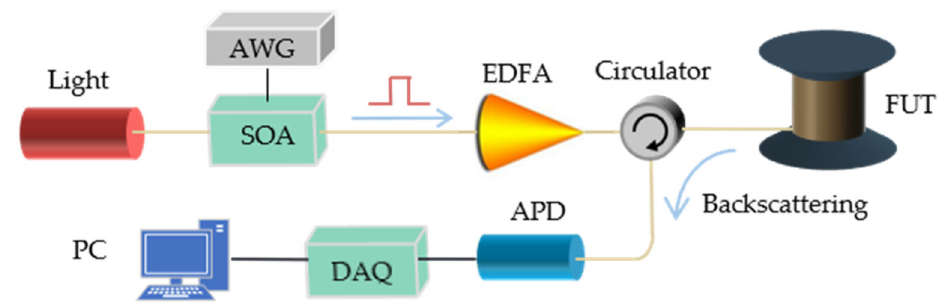
Figure 1. Schematic diagram of DVS system. SOA: semiconductor optical amplifier, AWG: arbitrary waveform generator, EDFA: erbium-doped fiber amplifier, FUT: fiber under test, APD: avalanche photodetector, and DAQ: data acquisition